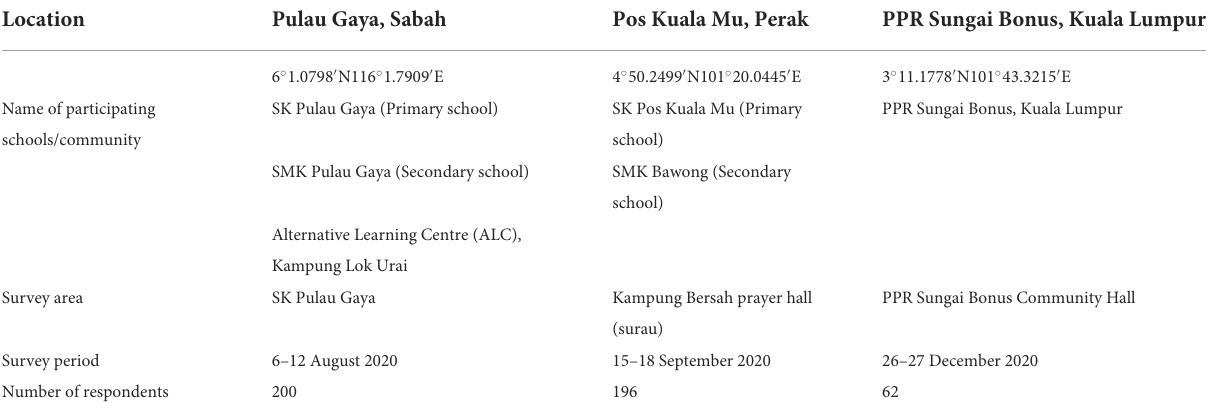
TABLE 2 Details of participants in the community